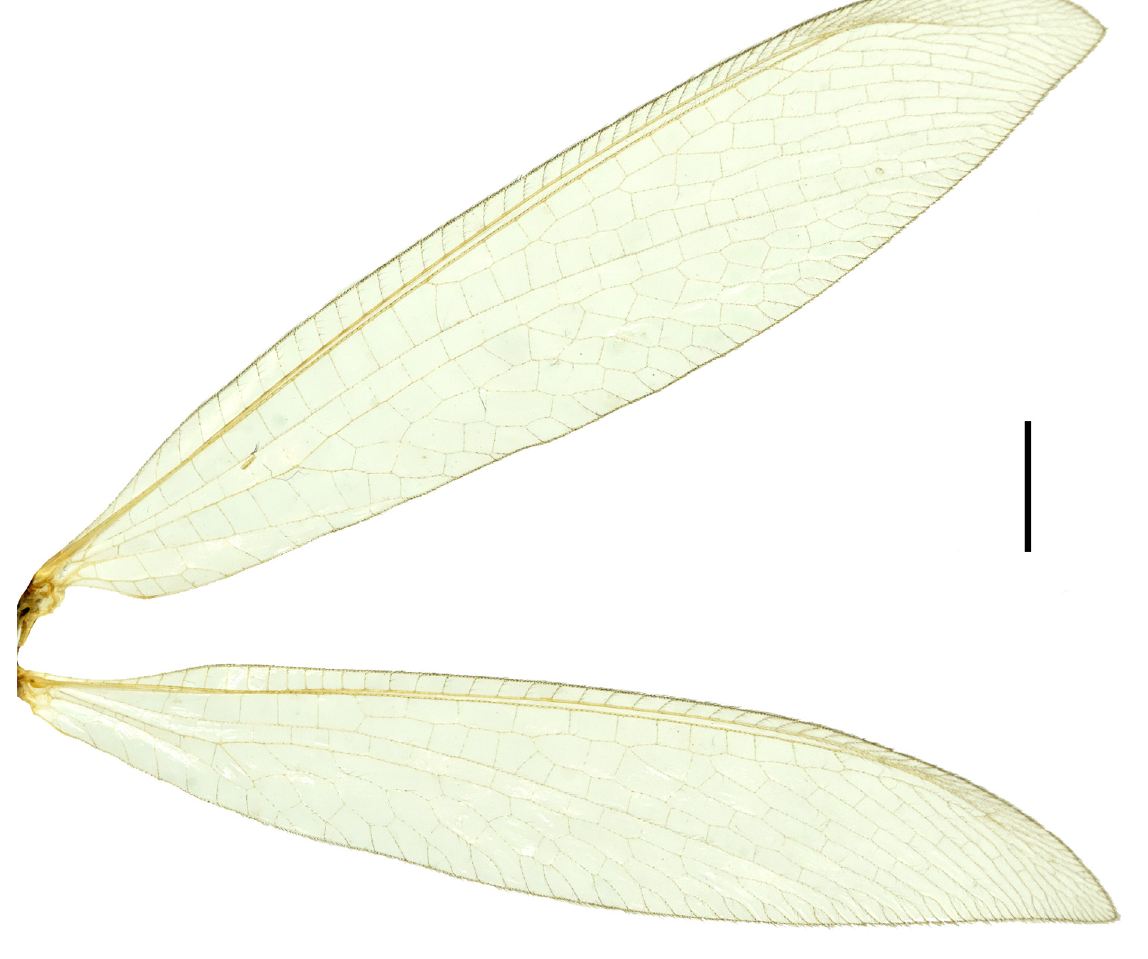
Fig. 13. Myrmeleon hyalinus hyalinus Olivier, 1811 (CAUPK000024). Right fore- and hind wing. Scale bar = 5.0